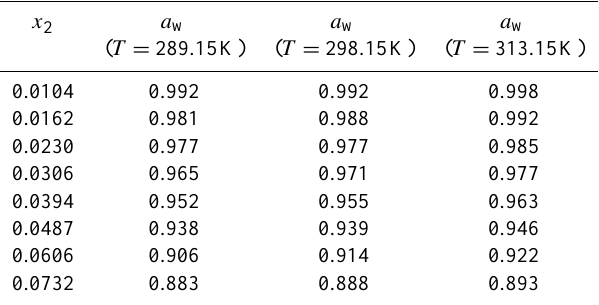
Table A8. Bulk water activity (a w ) measurements a of water (1) + sucrose (2) solutions at three different temperatures. Solution compositions are given in mole fraction of the organic component (2), x 2 . x